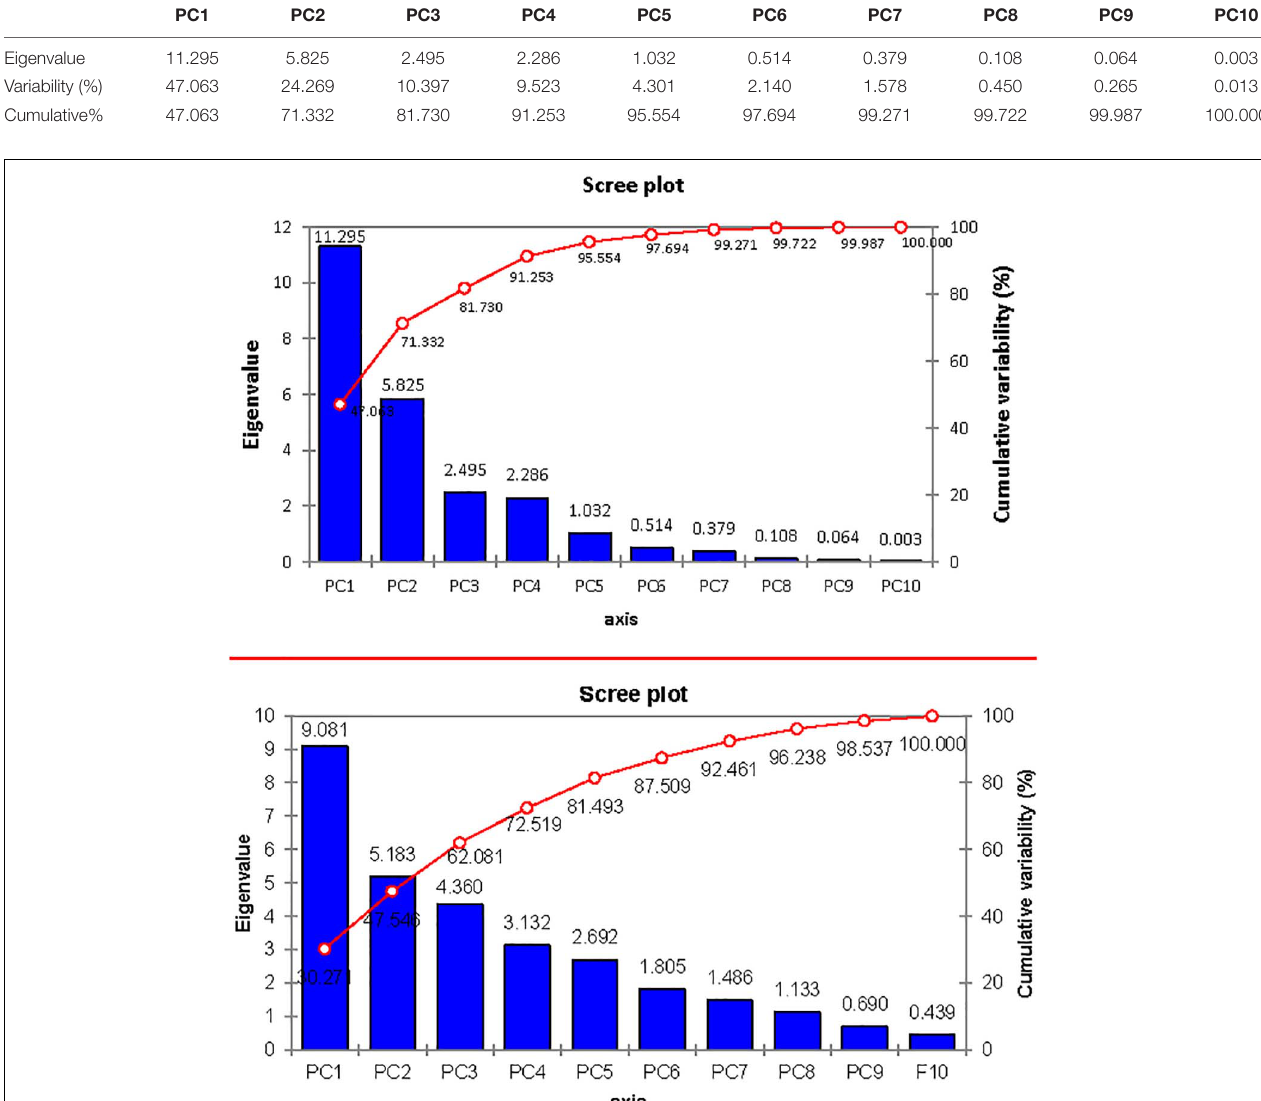
TABLE 14 | Principal component analysis for morphophysiological traits under control and salt stress conditions in different cotton genotypes. PC1 PC2